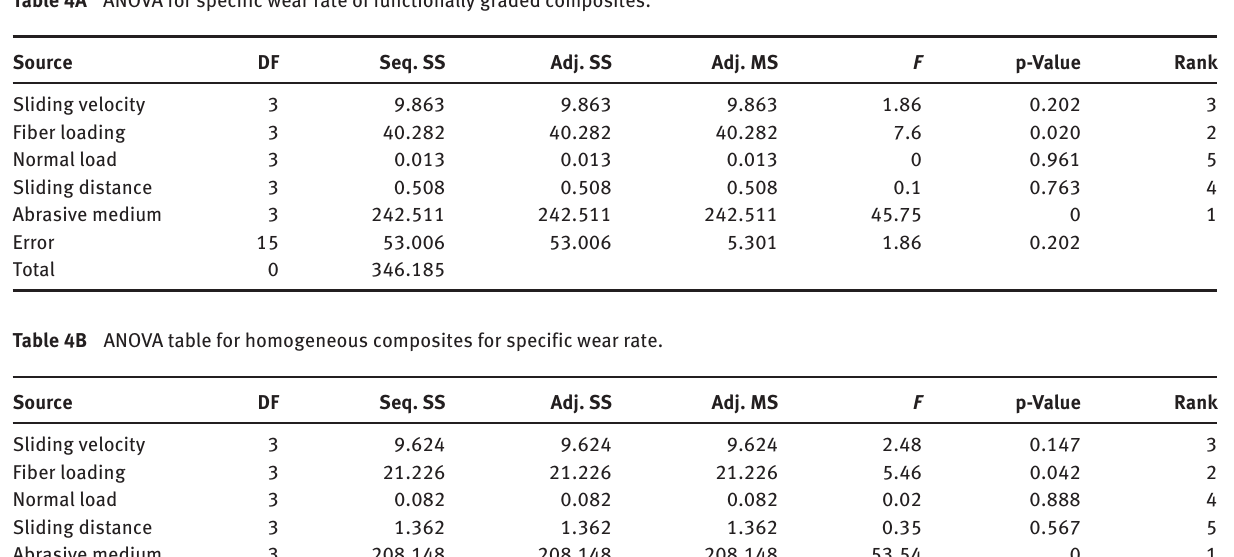
Table 4A ANOVA for specific wear rate of functionally graded composites.